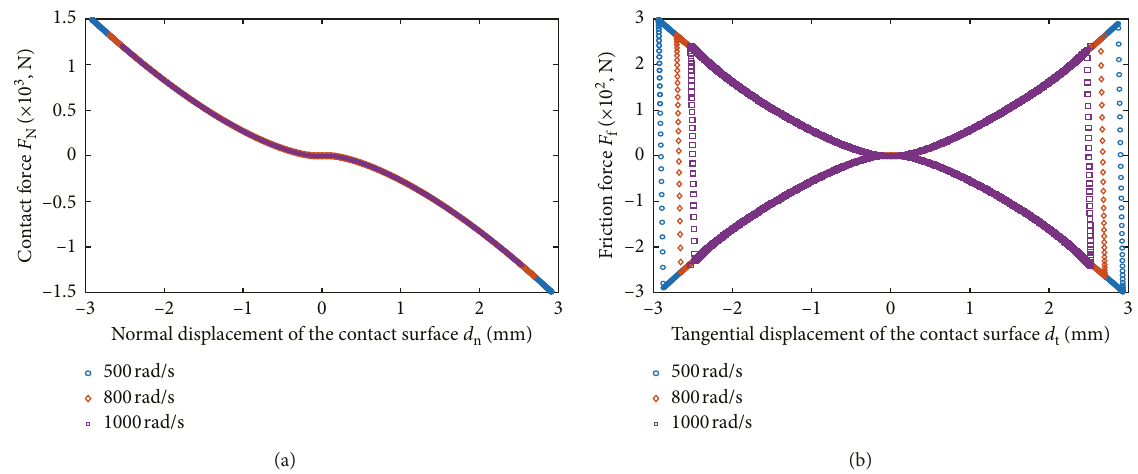
Figure 5: The curves of force at different speeds. (a) Contact forces. (b) Friction